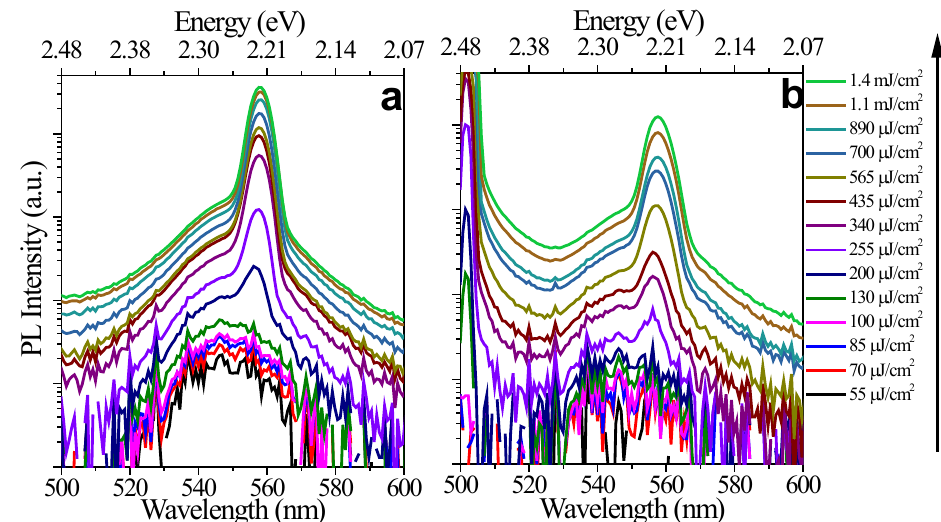
Figure 2. Evolution of the PL spectra with a pulse energy density under ( a ) 440 nm and ( b ) 500 nm excitation.